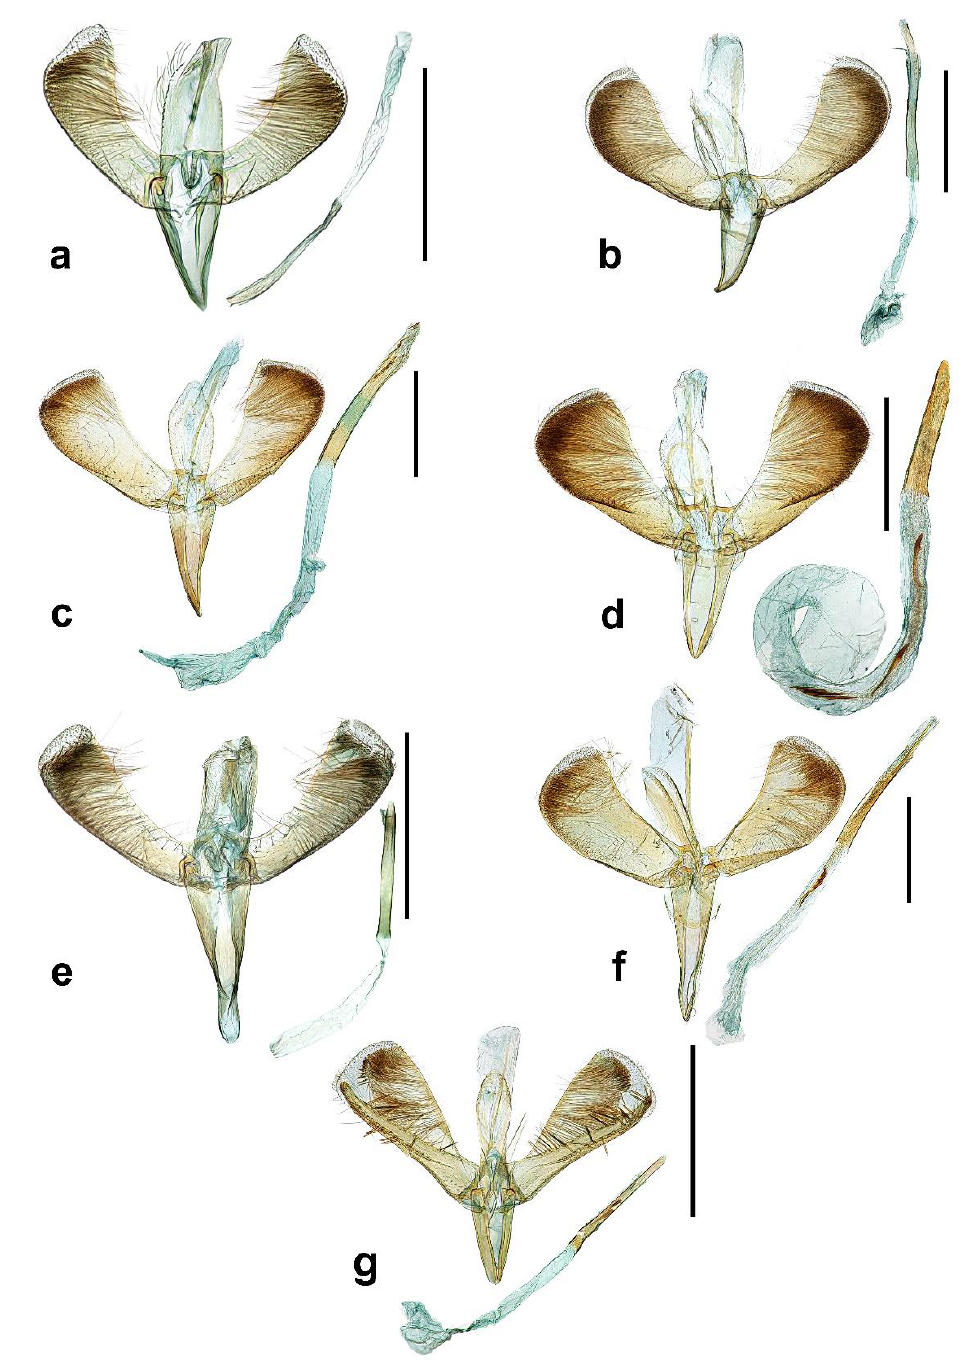
Figure 2. Male genitalia of Caloptilia . ( a ). C. purpureus (gen. slide no. HNUSEL-5592); ( b ). C. acericola (gen. slide no. HNUSEL-5571); ( c ). C. celtidis (gen. slide no. HNUSEL-5561); ( d ). C. dentata (gen. slide no. HNUSEL-5549); ( e ). C. kadsurae (gen. slide no. HNUSEL-5593); ( f ). C . recitata (gen. slide no. HNUSEL-5544); ( g ). C. soyella (gen. slide no. HNUSEL-5556, 5557) (Scale bars: a – g = 5 mm). Forewing ground color grayish fuscous, tinged with violet reflection; a yellow dorso- basal streak from base to 1/6 of forewing; large and rounded yellow blotch begins at 1/3 to base and extends to wing fold, the interval between blotch and dorsal margin broadens more apically and tiny blackish dots sparsely on costal margin; venation with R 1 arising from before middle, R 2 arising from 2/3 of cell, R 3 , R 4 and R 5 not close, M2 and M3 stalked, M3 and CuA close near discal end of cell. Hindwing lanceolate and ground color